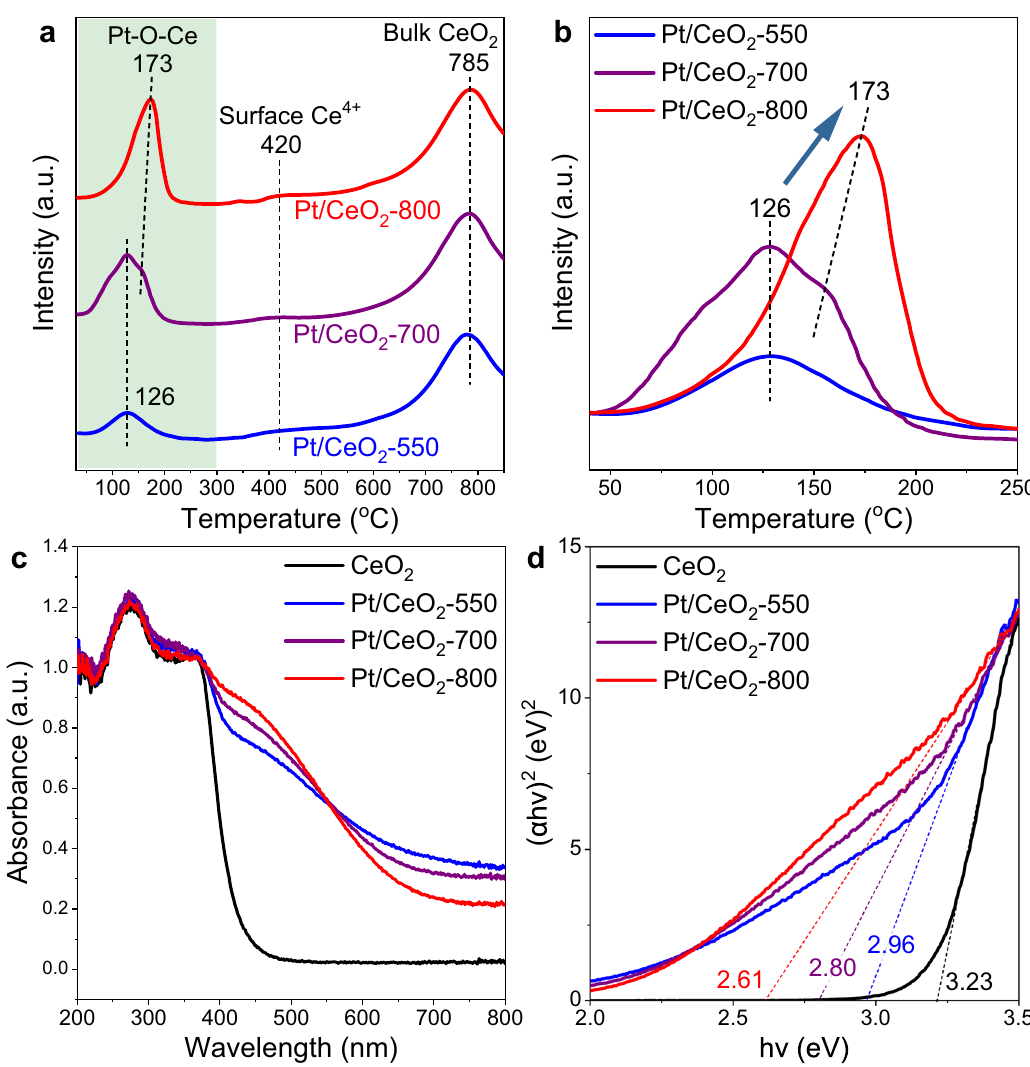
Fig. 2 | Pt-CeO 2 interaction determined by H 2 -TPR and UV – Vis spectra. a , b H 2 -TPR pro fi les for Pt/CeO 2 -X catalysts; c UV – Vis spectra of CeO 2 support and Pt/CeO 2 -X catalysts; d the plots of ( α hv ) 2 vs. photon energy ( hv ) for CeO 2 support and Pt/CeO 2 -X catalysts (X=550, 700 and